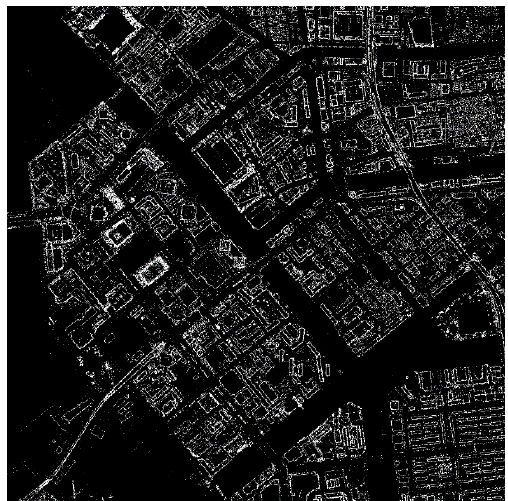
Figure 10. Result in the step